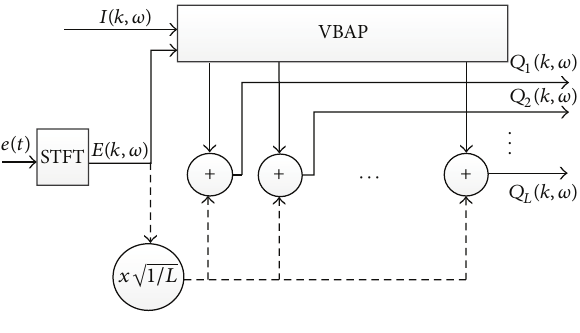
Figure 7: Synthesis stage of the proposed method for loudspeaker